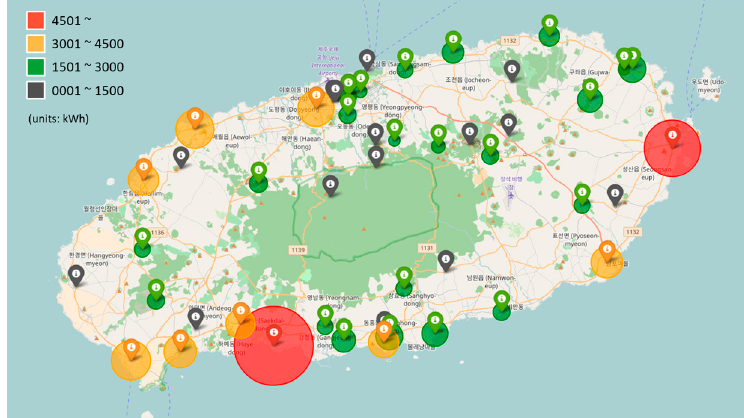
Figure 11. Visualization of the distribution of the estimated electric power consumption for charging electric vehicles on Jeju island using the proposed system in May